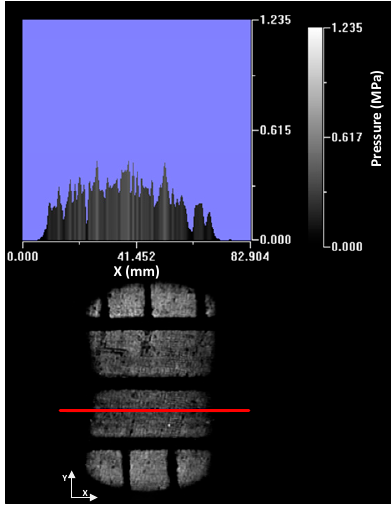
Figure 20. Longitudinal profile.